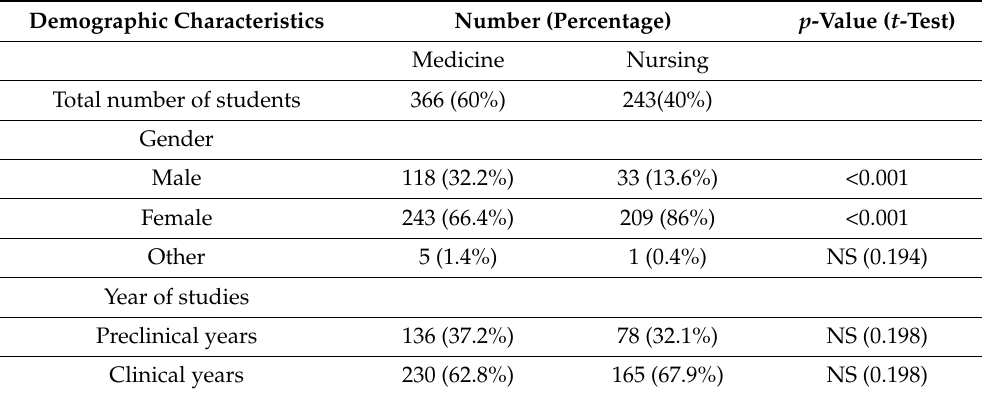
Table 1. Demographic characteristics of the study population (n = 609). Demographic